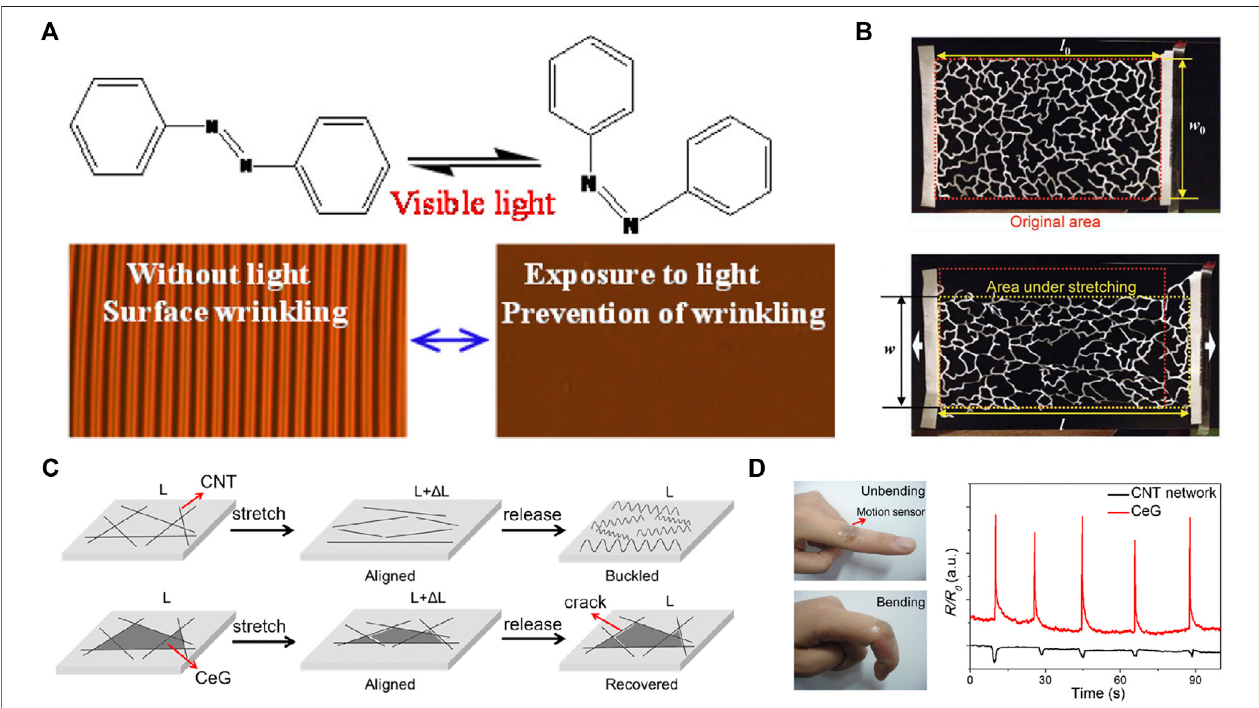
FIGURE3| Wrinklesuppressionthrough fi lmstiffnessmodulation. (A) MechanismofthephotoisomerizationprocessofthePAAB fi lm(top)andthereversiblelight- triggered de-wrinkling (bottom) (reproduced with permission from Ji et al., 2016, The American Chemical Society). (B) Unstretched (top) and stretched (bottom) AuNM- PDMSelectrode,withlateralPoisson ’ swrinklessuppressed withlargetensilestrain(reproducedwithpermissionfromWangetal.,2019,Wiley-VCH). (C) Mechanismof buckle suppression of the CNT fi lm through graphene hybridization. (D) Comparison between a CeG-based strain sensor and a CNT-based strain sensor in detecting a strain by fi nger bending (reproduced with permission from Shi et al., 2016, Wiley-VCH).